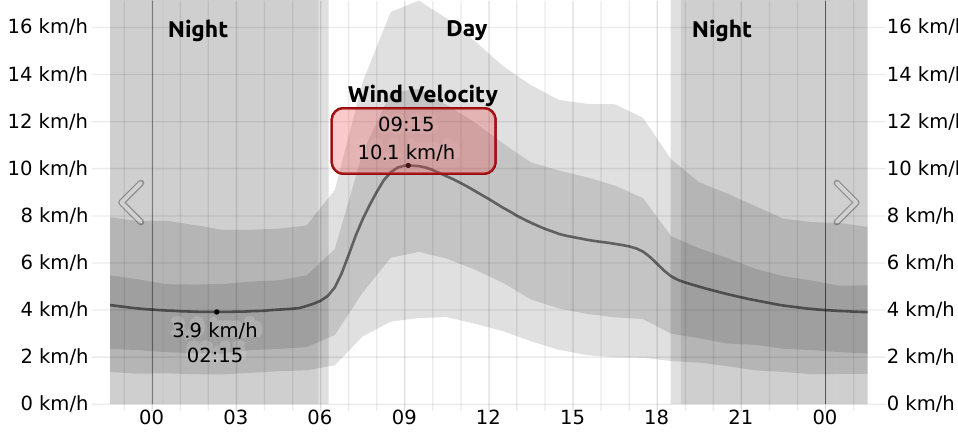
Figure 10. Wind velocity during experiment.